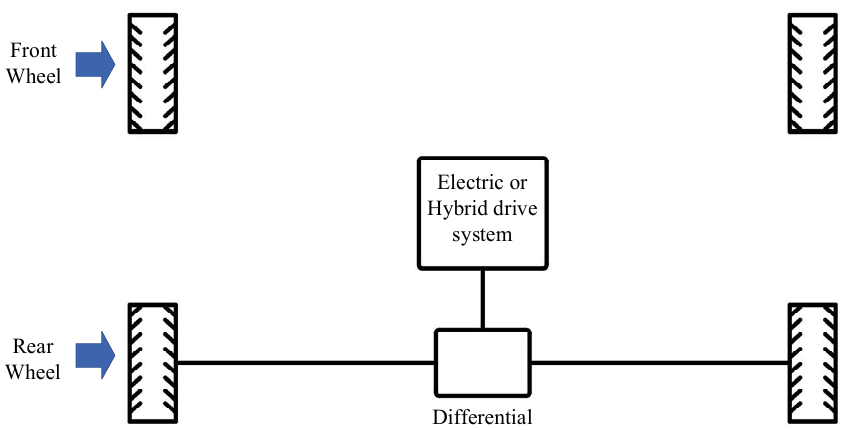
Figure 6. The layout structure of the power system of an ordinary front-wheel steering HEV bus.